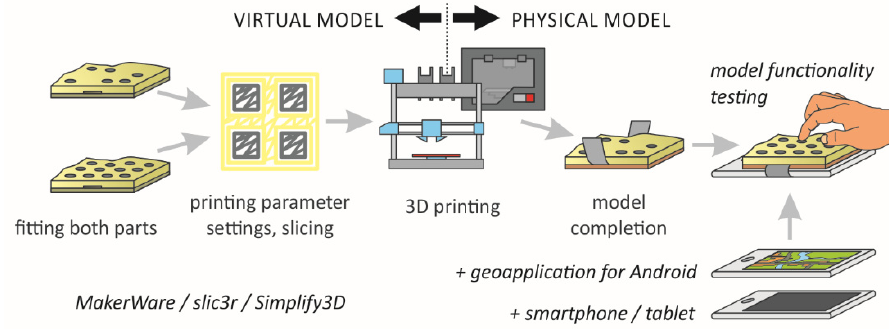
Figure 11. 3D printing block and map finalization scheme of the tactile map creation workflow.